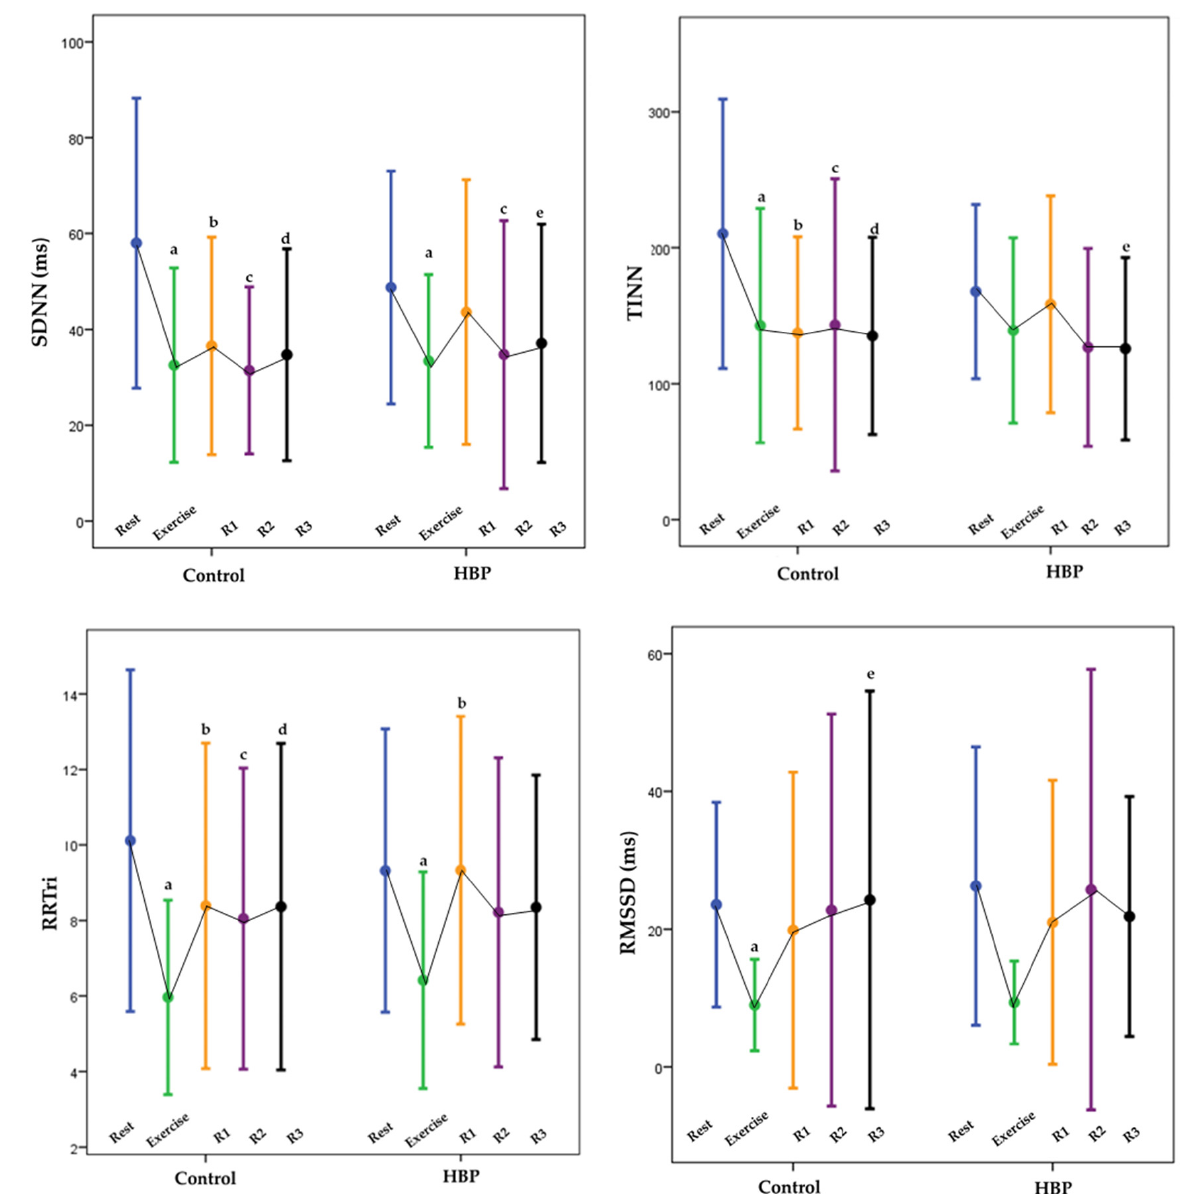
Figure 2. Comparative analysis of HRV (SDNN, TINN, RRTri, and RMSSD) during rest, aerobic exercise, and recovery. MANOVA test (Mean ± SD), HBP (high blood pressure group), Control (Control Group), (R1) recovery period 1—first 5 min of the recovery period, (R2) recovery period 2—between the 10th and 15th min of the recovery period, (R3) recovery period 3—between the 25th and 30th min of the period recovery, (ms) ms, (SDNN) standard deviation of all normal RR intervals recorded at an interval of time, (bpm) beats per min, (RMSSD) root mean square of the square of differences between adjacent normal RR intervals in an interval of time, (TINN) triangular interpolation histogram of RR intervals, (RRtri) triangular index, and (SD) standard deviation. (a) Post hoc test found differences when comparing rest with exercise, (b) post hoc test found differences when comparing rest with R1, (c) post hoc test found differences when comparing rest with R2, (d) post hoc test found differences when comparing rest with R3, and (e) post hoc test found differences when comparing R1 with